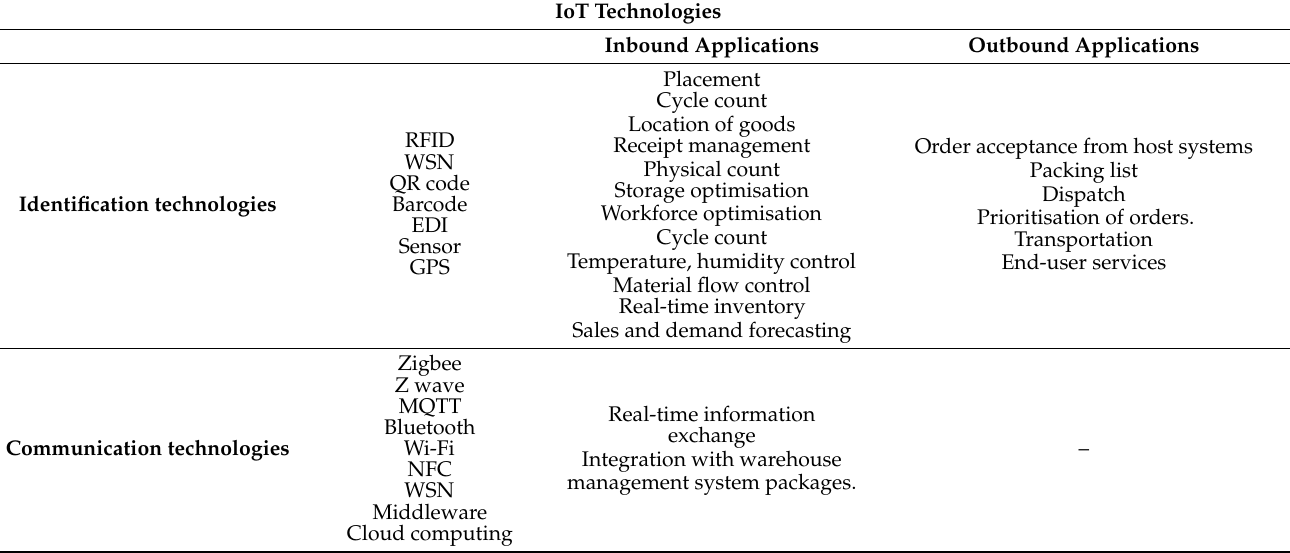
Table 1. Primary IoT technologies